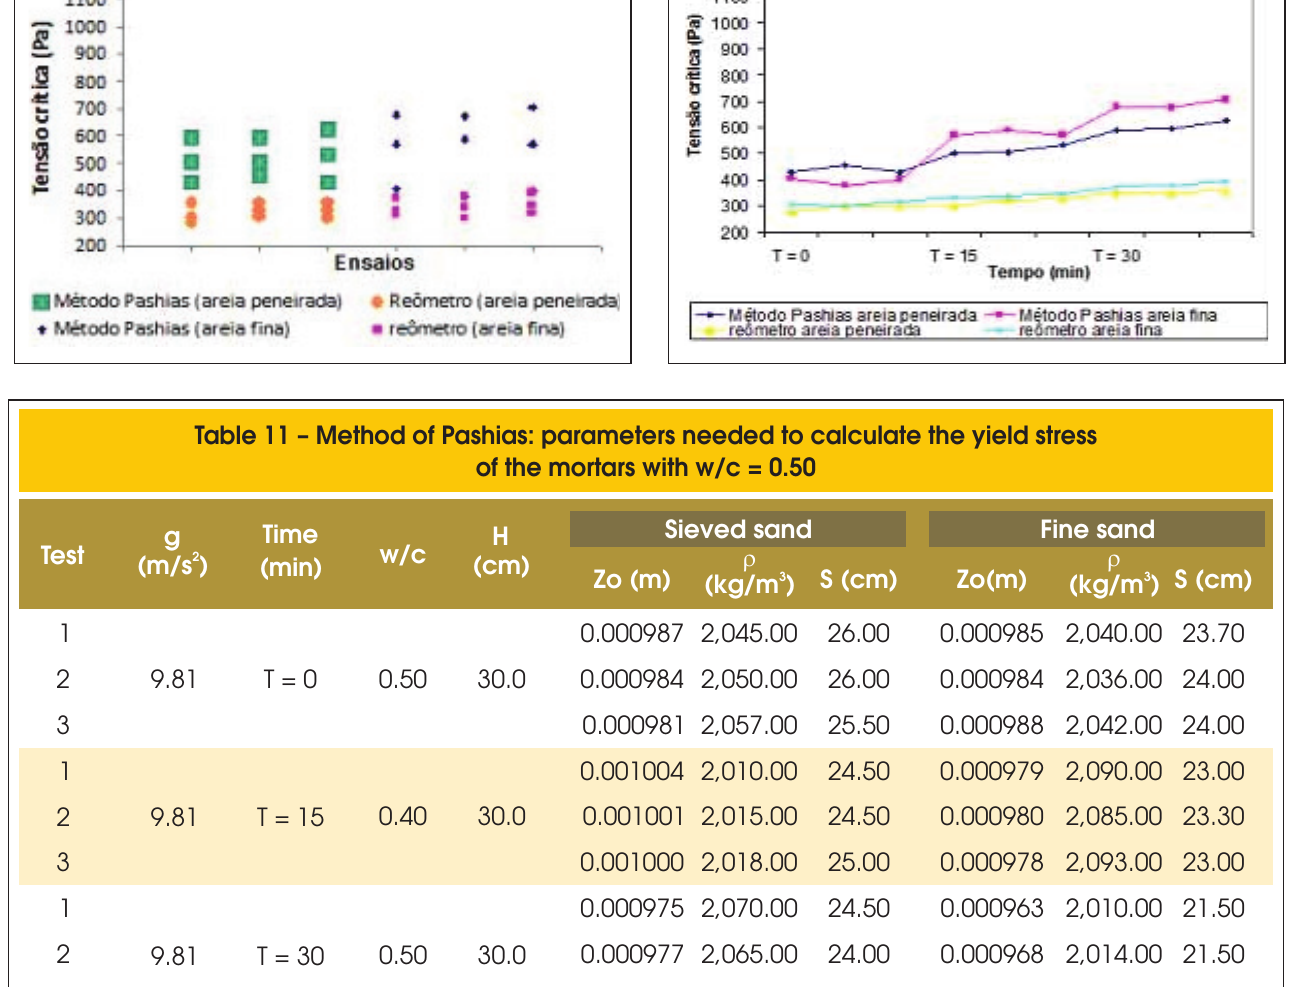
Figure 13 – Behavior of the yield stress as a function of time for mortars with w/c = 0.45